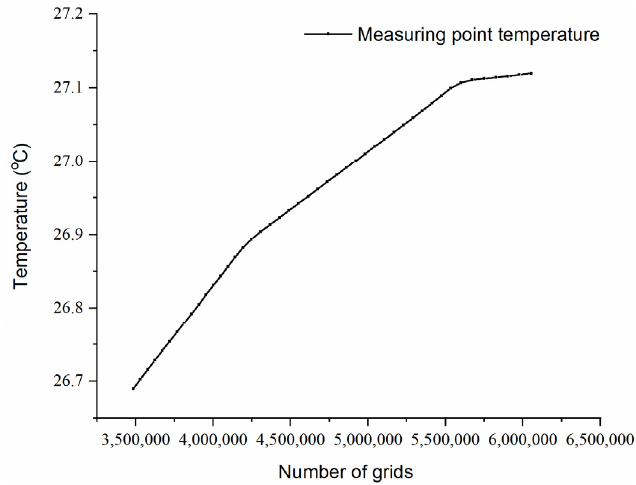
Figure 13. Grid independence analysis assessment.